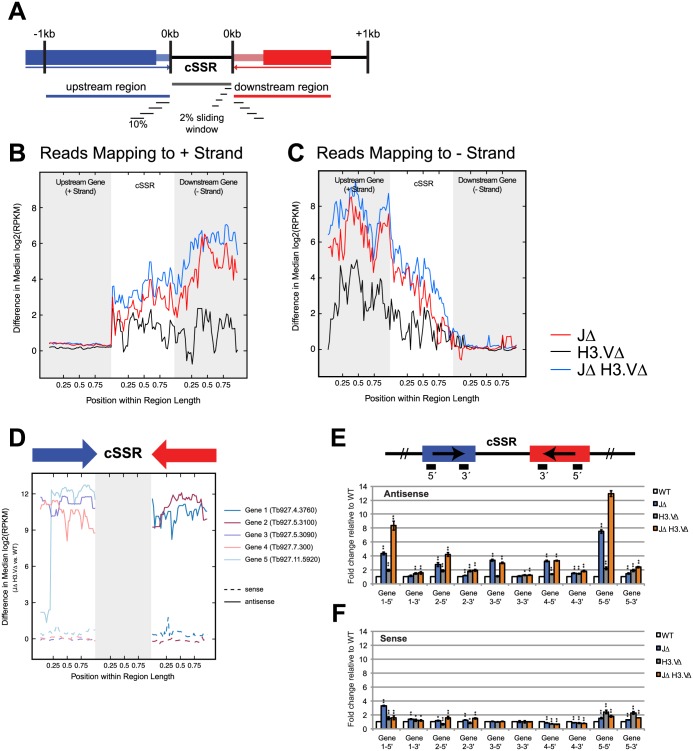
Base J and H3.V are required for proper transcription termination at cSSRs.(A) Diagram of windows used to compute values. Here, we defined the cSSR as a 1 to 5 kb long region between the 3´ UTRs of the last genes of converging PTUs. 3´ UTRs are depicted as thinner, lighter boxes. The regions 1 kb upstream and downstream of a given cSSR of interest (up to 1kb in length) and the cSSR itself were divided into 10% sliding intervals with a step size of 2% to ensure an equal number of intervals for comparison. If the cSSR flanking gene is less than 1 kb long, only the region spanning the full length of the gene was used to calculate sliding windows. (B, C) Median difference in log2(RPKM) values were calculated between WT and mutant cells for sliding windows in each cSSR and cSSR proximal region. The mean difference for each window across all cSSRs and cSSR proximal regions was then calculated. Mean difference in expression for transcripts mapping to the positive strand (B) or negative strand (C) was plotted against the intervals along the cSSR and cSSR proximal region. (D) Median difference in log2(RPKM) values between WT and JΔ H3.VΔ for a representative set of five genes. Median differences were calculated for sense (dashed) and antisense (solid) transcripts. Arrows above denote the direction of transcription. Genes 1 through 5 are Tb927.4.3760, Tb927.5.3100, Tb927.5.3090, Tb927.7.300 and Tb927.11.5920 respectively. (E-F) Stranded q-PCR results for genes in (D). q-PCR was performed with probes specific to the 5´ and 3´ ends of each gene, according to schematic shown in (E). Antisense (E) and sense (F) transcript abundance with respect to WT is shown for each mutant. Random hexamer-primed TbURA3 was used for normalization. * indicates P < 0.05 and ** P < 0.01.